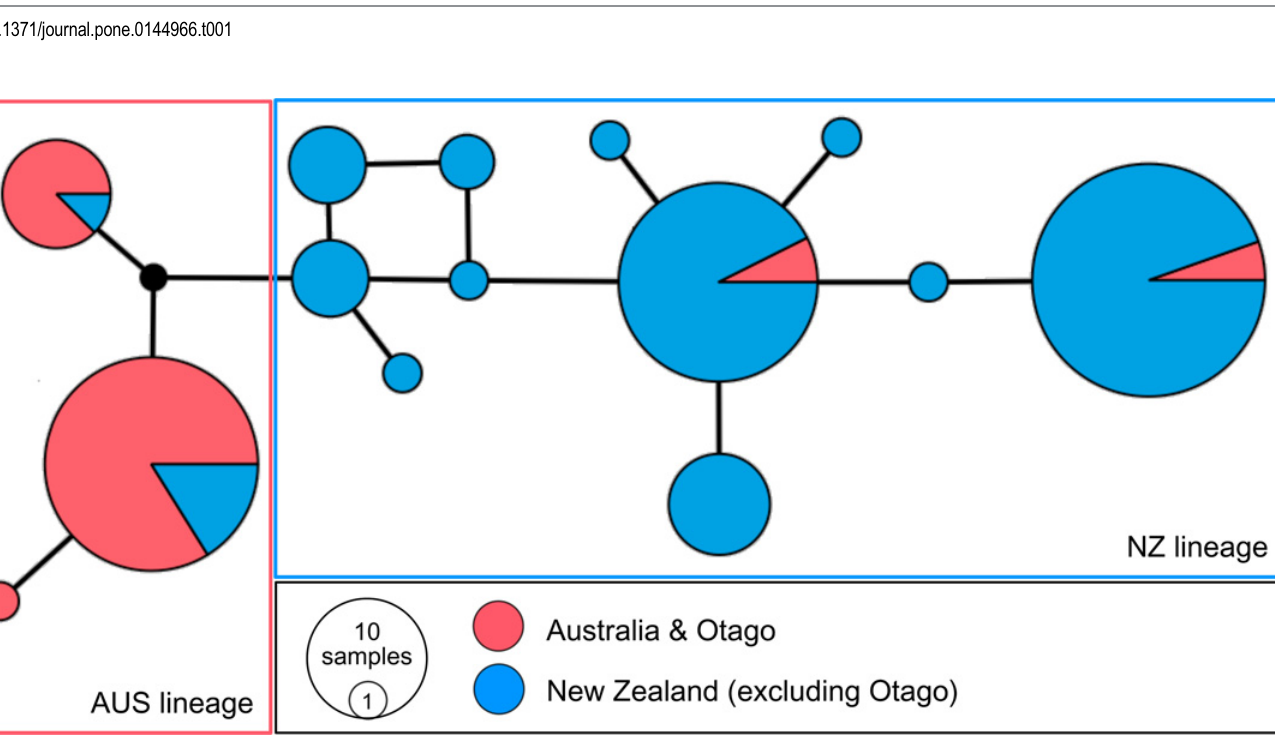
Fig 4. Median-joining network of Eudyptula β -fibrinogen intron 7 alleles. Circle size is proportional to allele frequency. Colours represent sampling locations from Australia and Otago (red) and all other NZ locations (blue). Edges between alleles represent single mutational steps. The red and blue boxes contain alleles associated with AUS and NZ lineages of E . minor ,